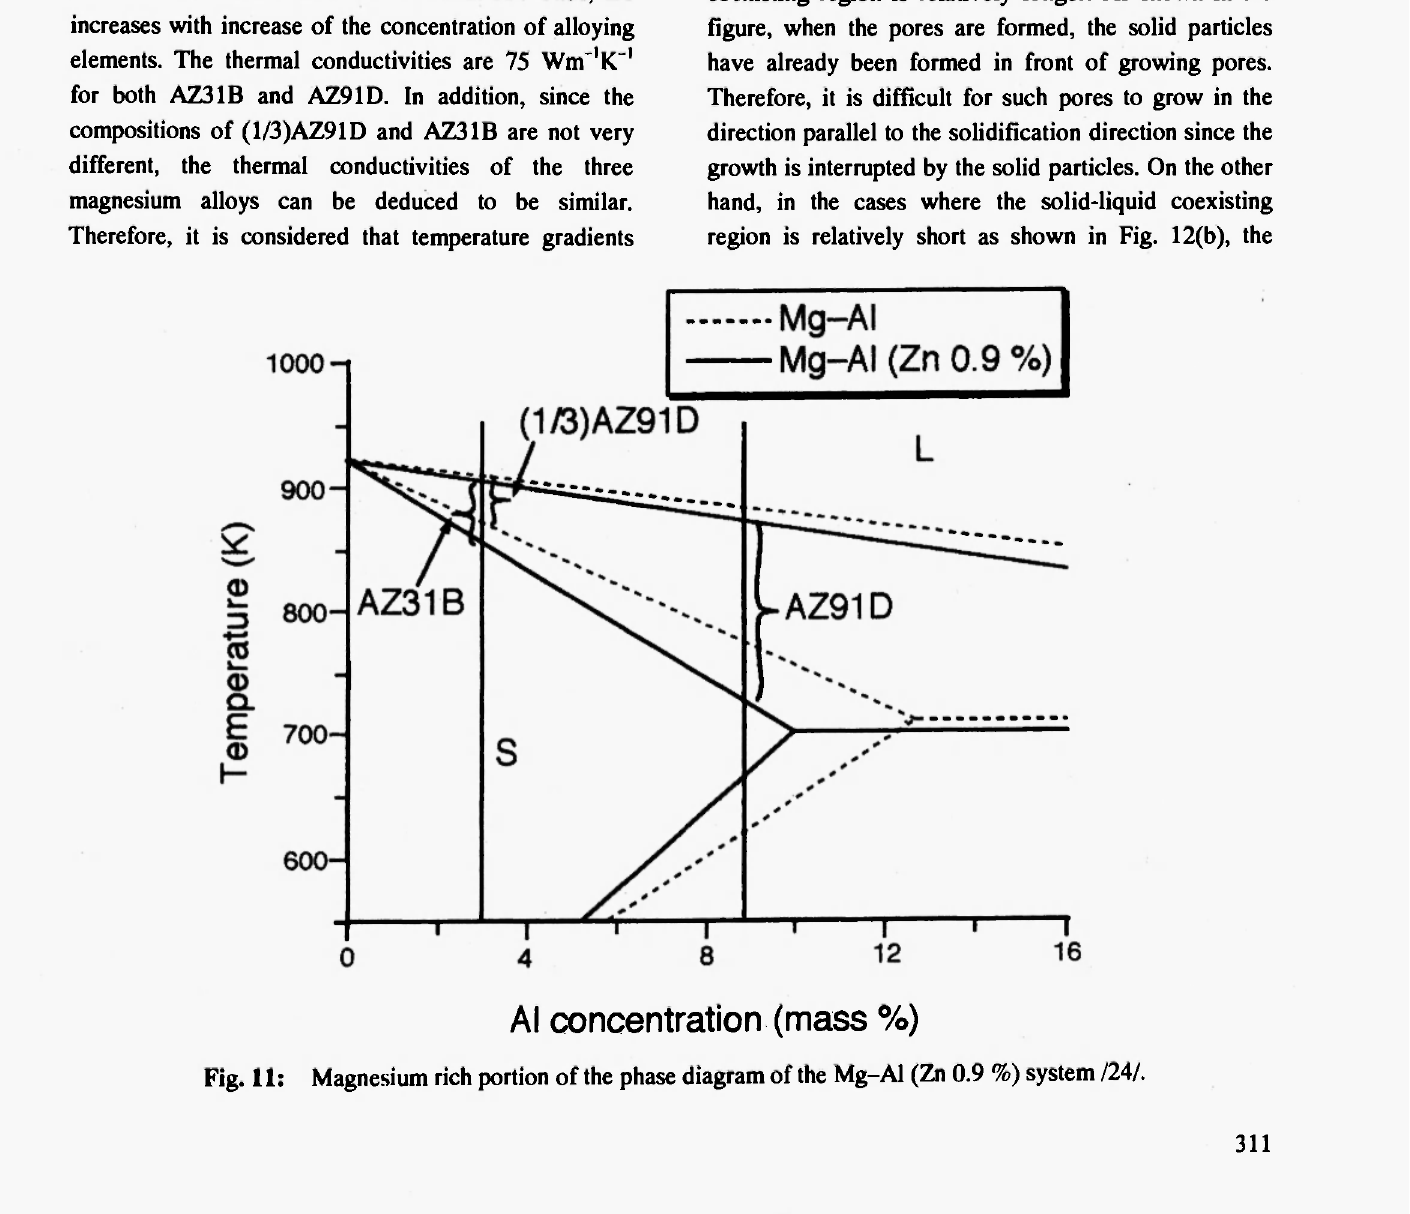
Fig. 11: Magnesium rich portion of the phase diagram of the Mg-Al (Zn 0.9 %) system